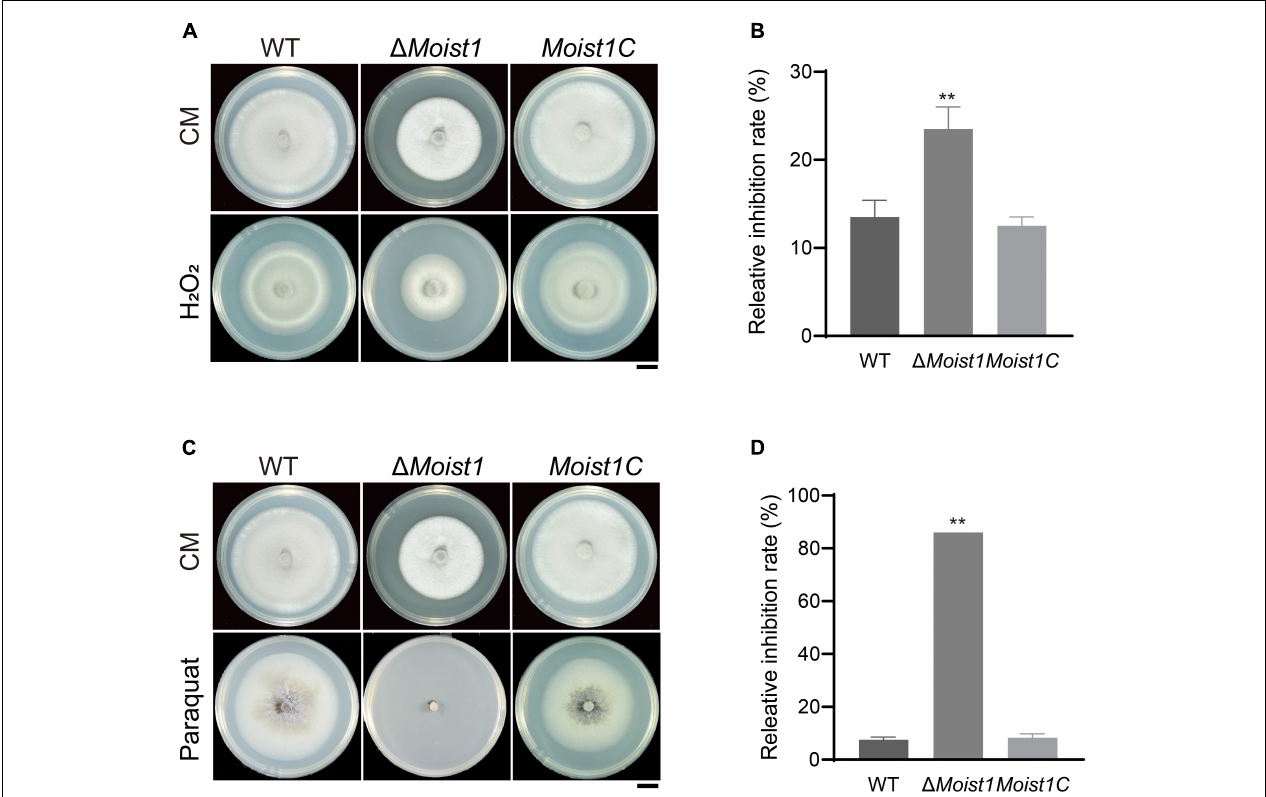
FIGURE 5 | Deletion of MoIst1 increases sensitivity to oxidative stress. (A) Hydrogen peroxide (H 2 O 2 , 10 mM) was added separately to CM to culture WT, (cid:49) Moist1, and Moist1C . Bar = 1 cm. (B) Relative inhibition rates of WT, (cid:49) Moist1 and Moist1C on CM with 10 mM hydrogen peroxide (H 2 O 2 ). The standard deviation is represented by error bars. Tukey’s test was used to test significant differences: ** P < 0.01. (C) Paraquat (0.8 mM) was added separately to CM to culture WT, (cid:49) Moist1, and Moist1C . Bar = 1 cm. (D) Relative inhibition rates of WT, (cid:49) Moist1, and Moist1C on CM with 0.8 mM paraquat. The standard deviation is represented by error bars. Tukey’s test was used to test significant differences: ** P <